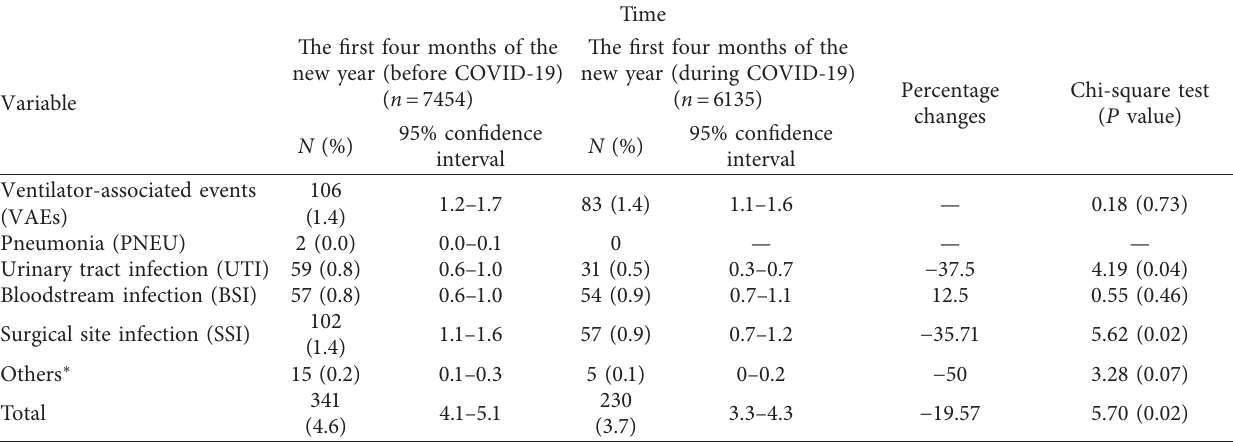
Table 1: Nosocomial infection rate before and during COVID-19